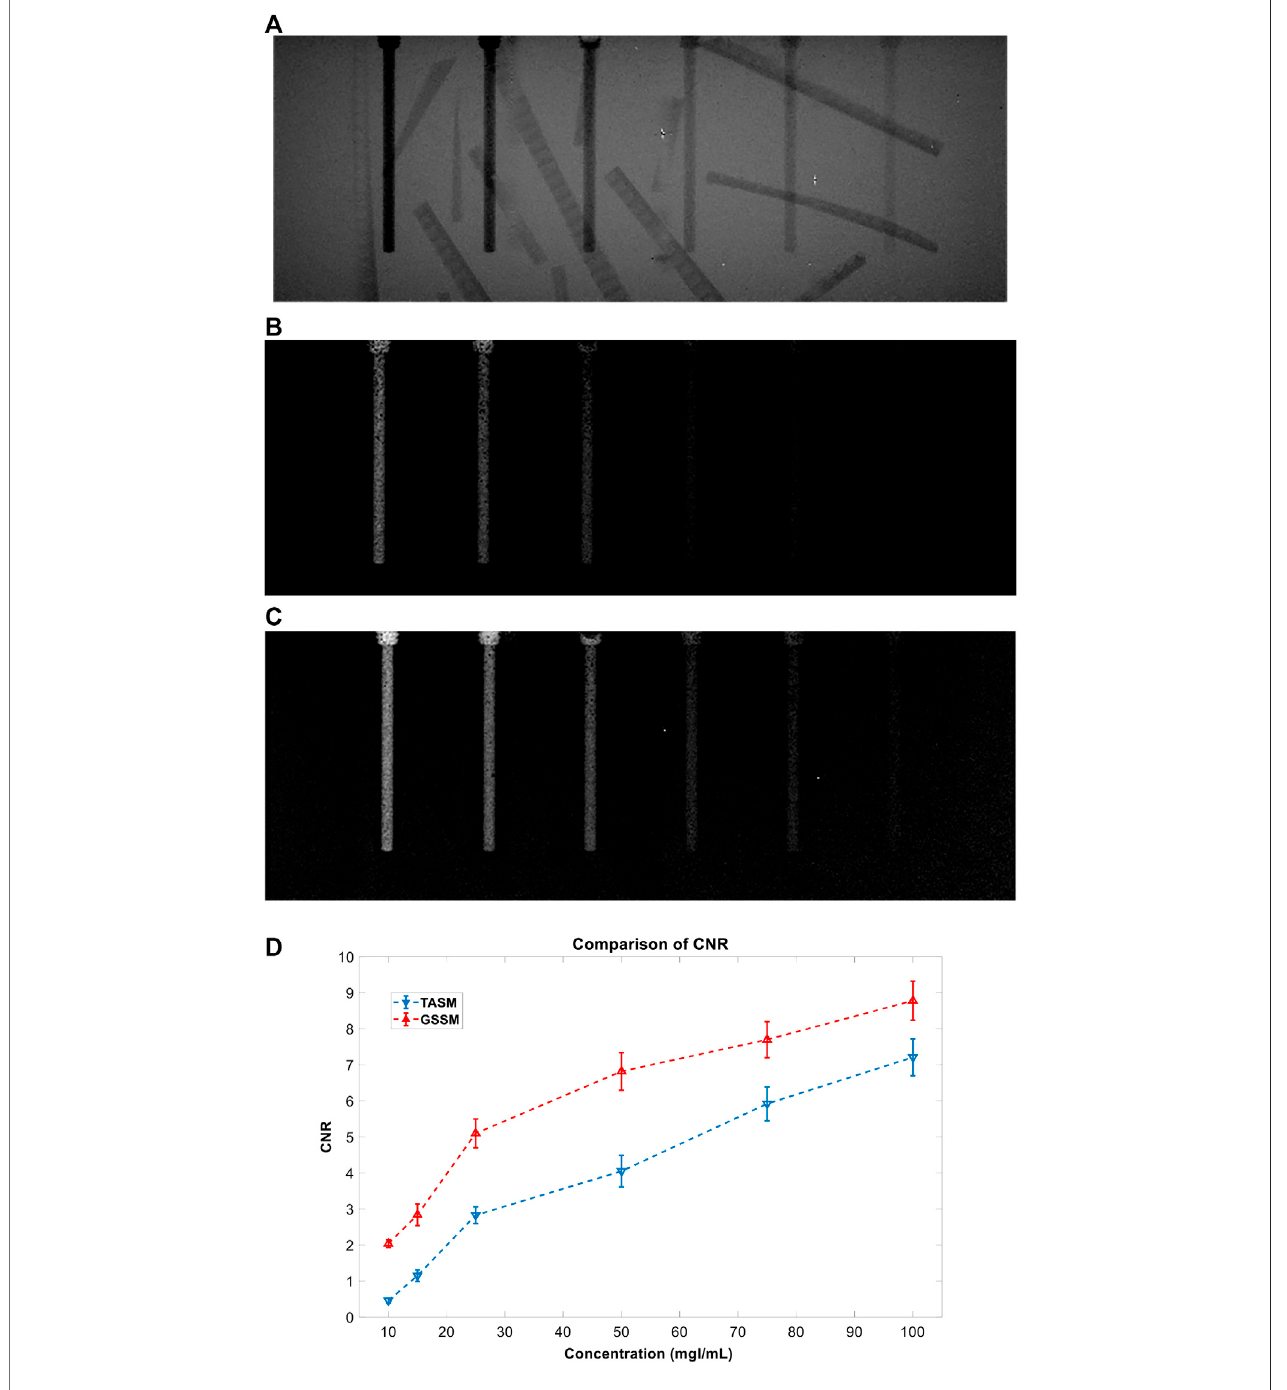
FIGURE12| Theresultsofcomparisonexperiment: (A) DRimage, (B) TASMdecompositionimage, (C) GSSMdecompositionimage,and (D) CNRcomparisonfor TASM and GSSM of the comparison experiment; the blue dashed line represents TASM CNR result and the red dashed line represents GSSM CNR result.